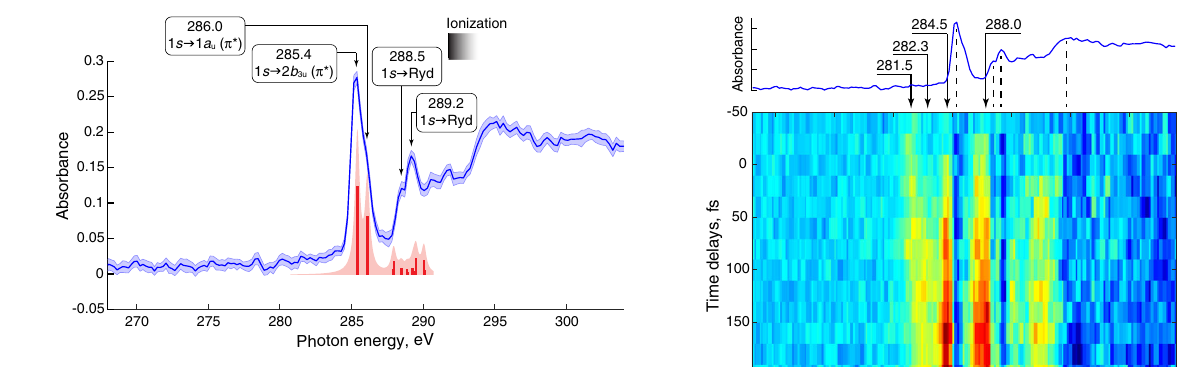
Fig. 2 Experimental and theoretical pyrazine absorption spectra in the ground electronic state. Experimental absorption spectrum (blue line). The shaded area covers 95% level of con fi dence (two standard deviations of 32 measurements). Numbers indicate the absorption peak positions in eV. The red bars and pink area correspond to the computed spectra (B3LYP/6-311 + + G**, shifted by + 10.7eV). Black shaded area shows the ionization threshold.